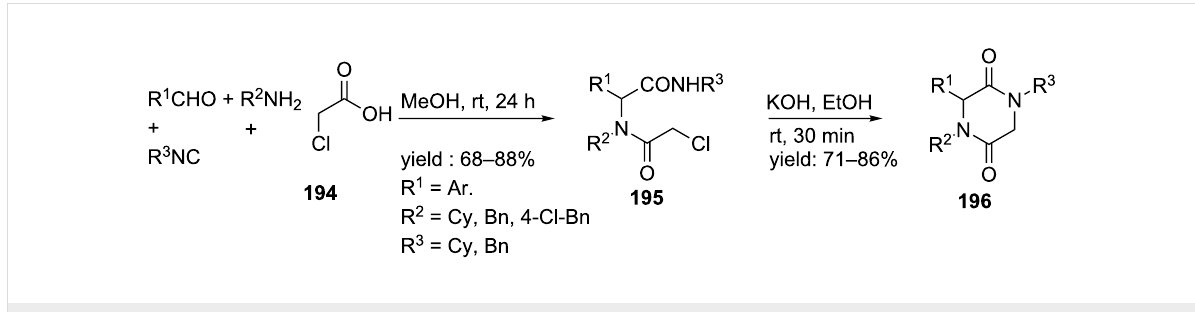
Scheme 59: The less common Ugi reaction towards DKPs, involving a S n 2-substitution.